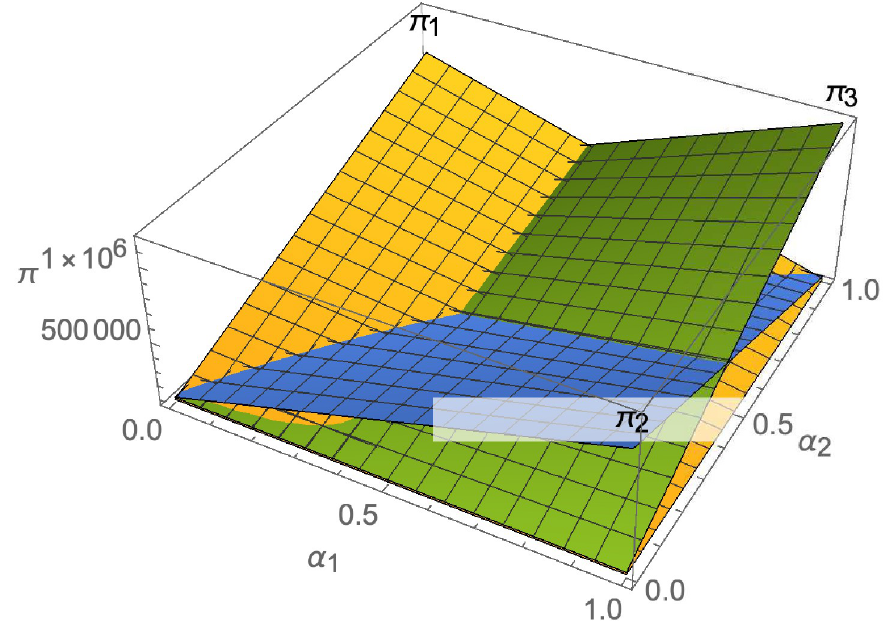
Fig 26. The impact of α 1 and α 2 on π 1 .